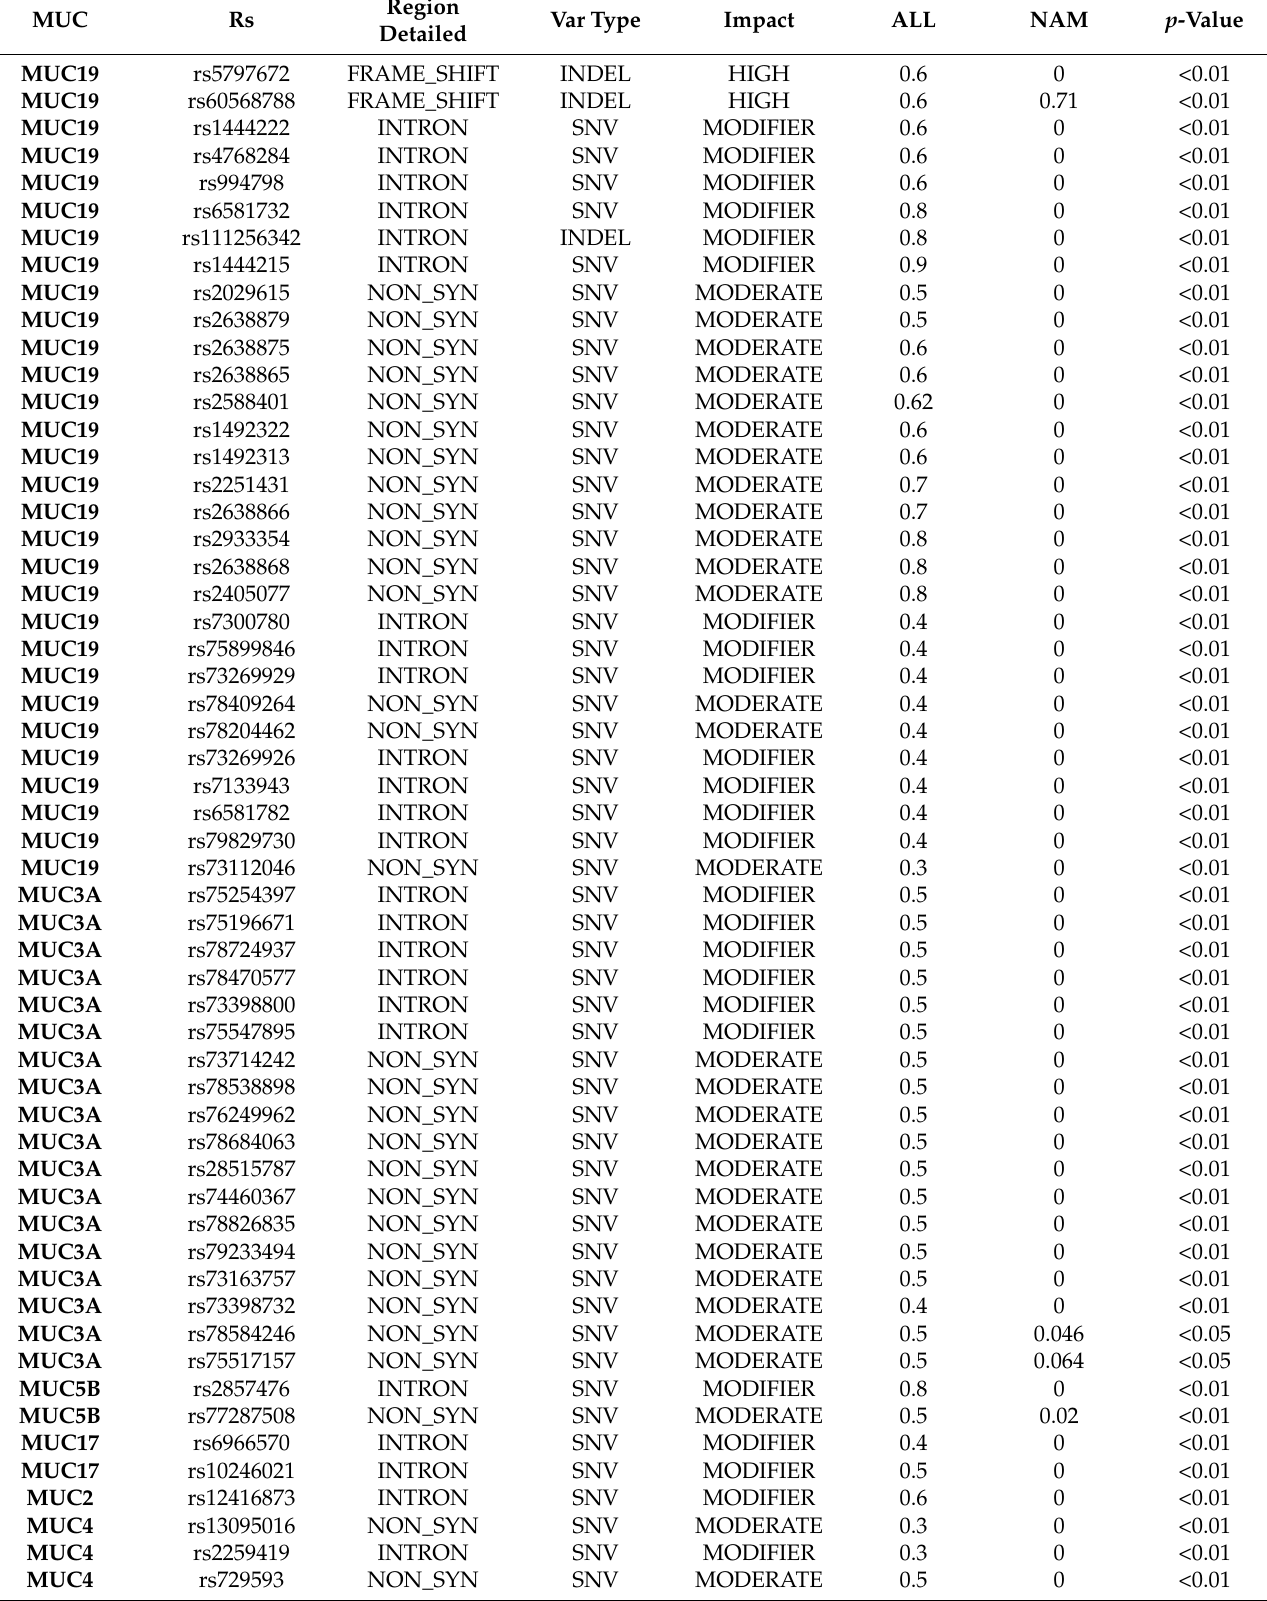
Table 1. Variants with significant difference between ALL vs. NAM